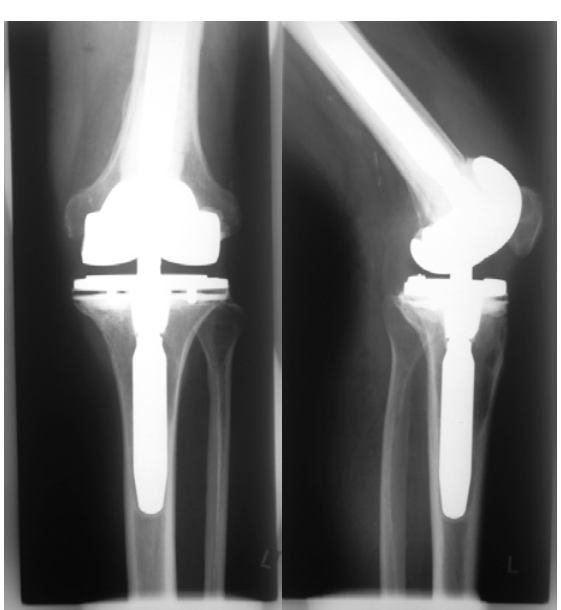
Figure 1. Patient 1, 2 months postoperative.